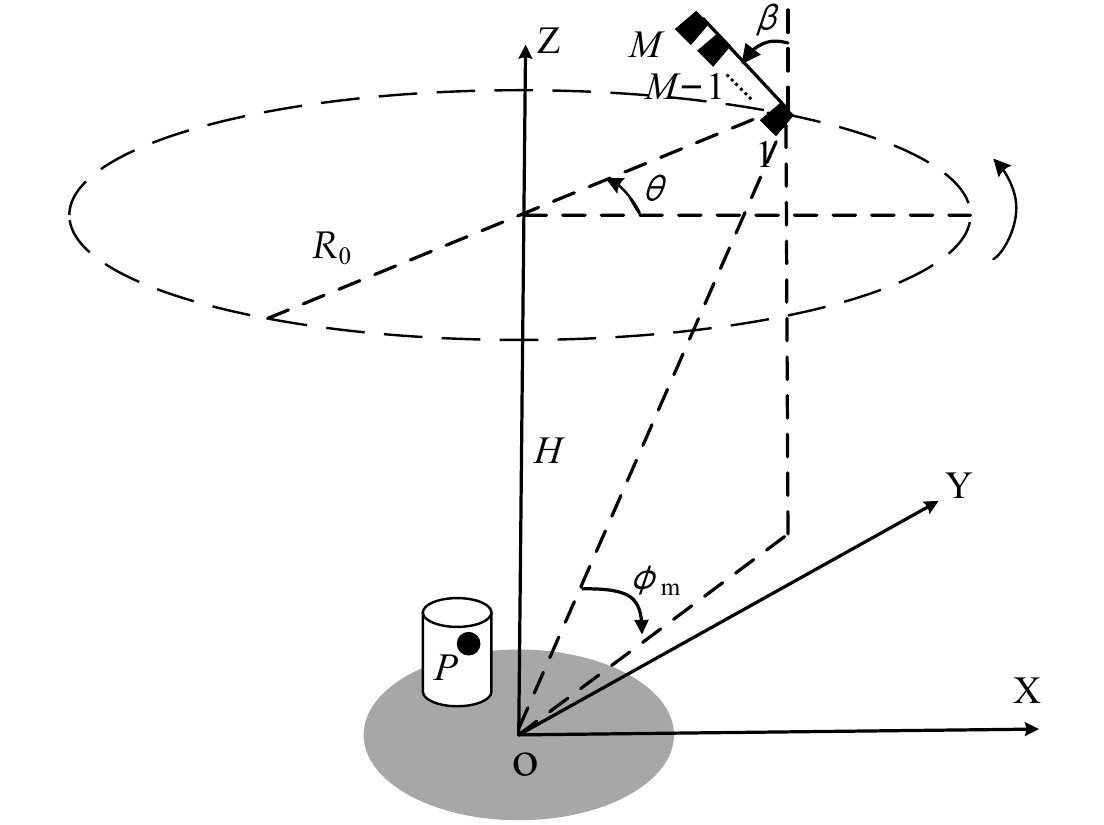
Figure 1. The imaging geometry of circular array synthetic aperture sonar.